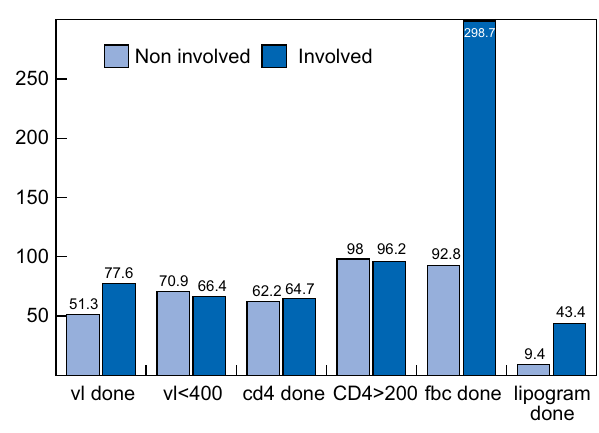
Figure 8: Six clinics with no evidence of audit stationery versus six clinics with best audit